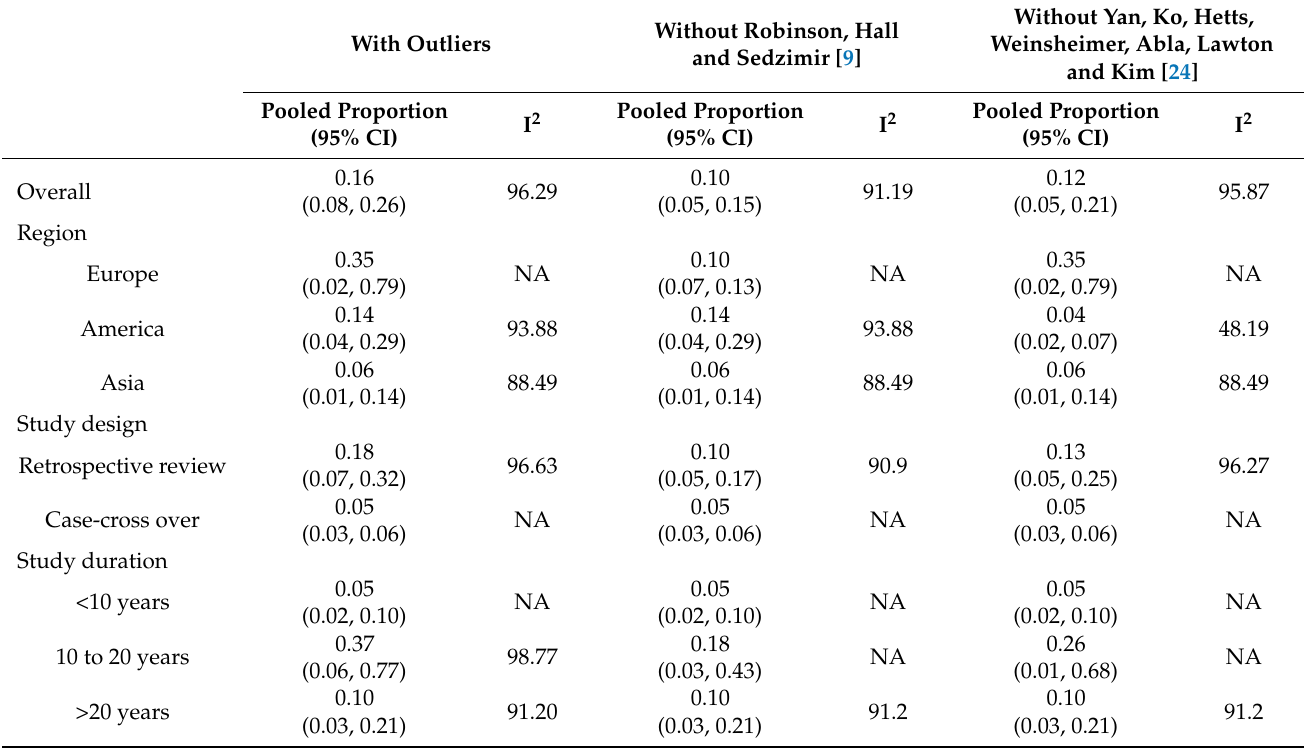
Table 6. Sensitivity analysis for outlier